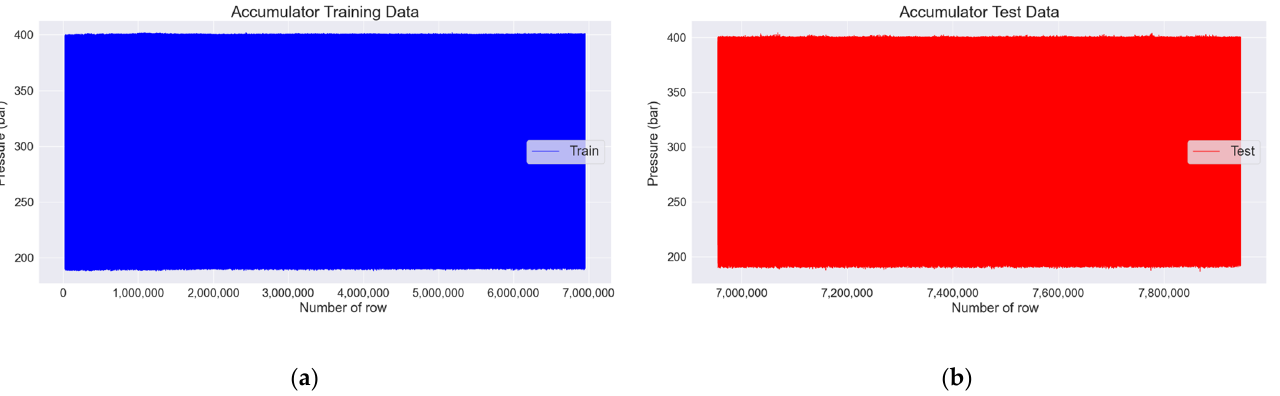
Figure 13. Visualization of pulsating pressure for training and test data. ( a ) Training data consisting of normal pulsating pressure; ( b ) test data consisting of abnormal pulsating pressure.